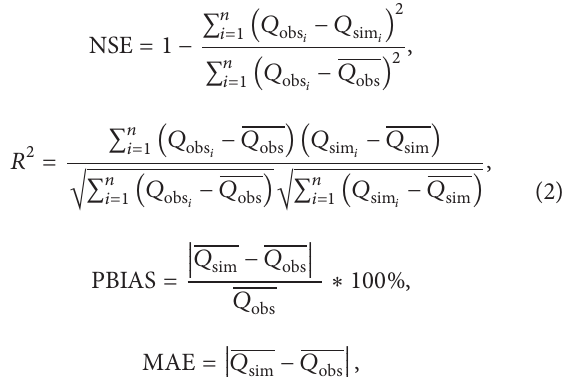
Figure 5: Comparison among annual SSC, runoff and NDVI in Da River